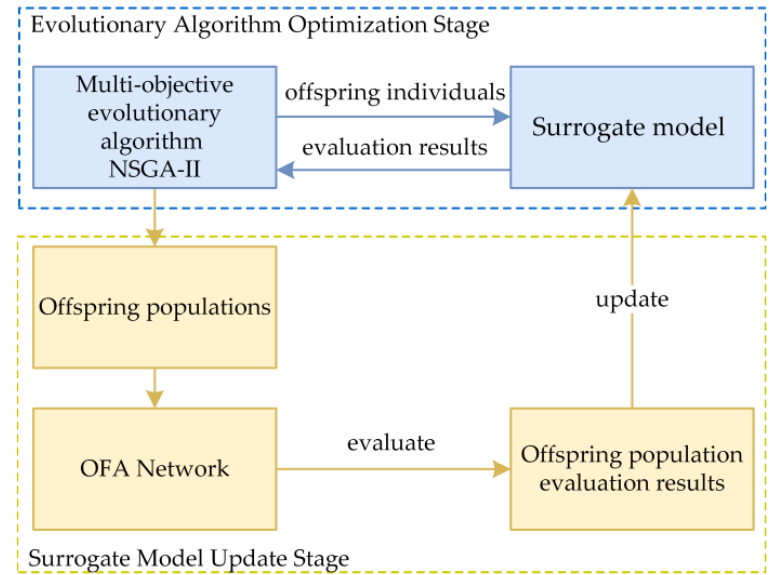
Figure 2. Online surrogate process.